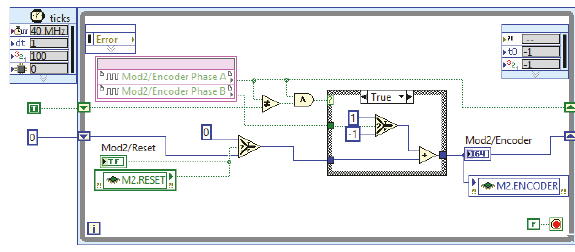
Figure 12: Structure used to read signals from encoders.